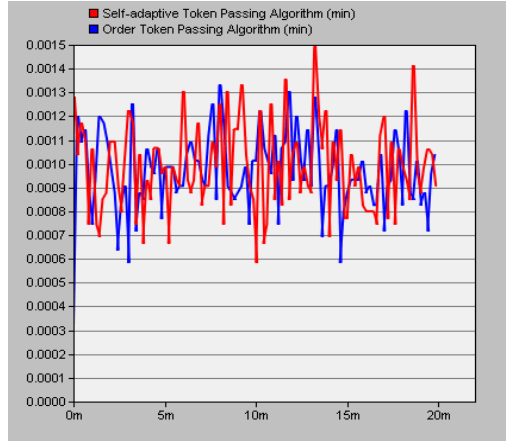
Fig.6 Improvement on token access